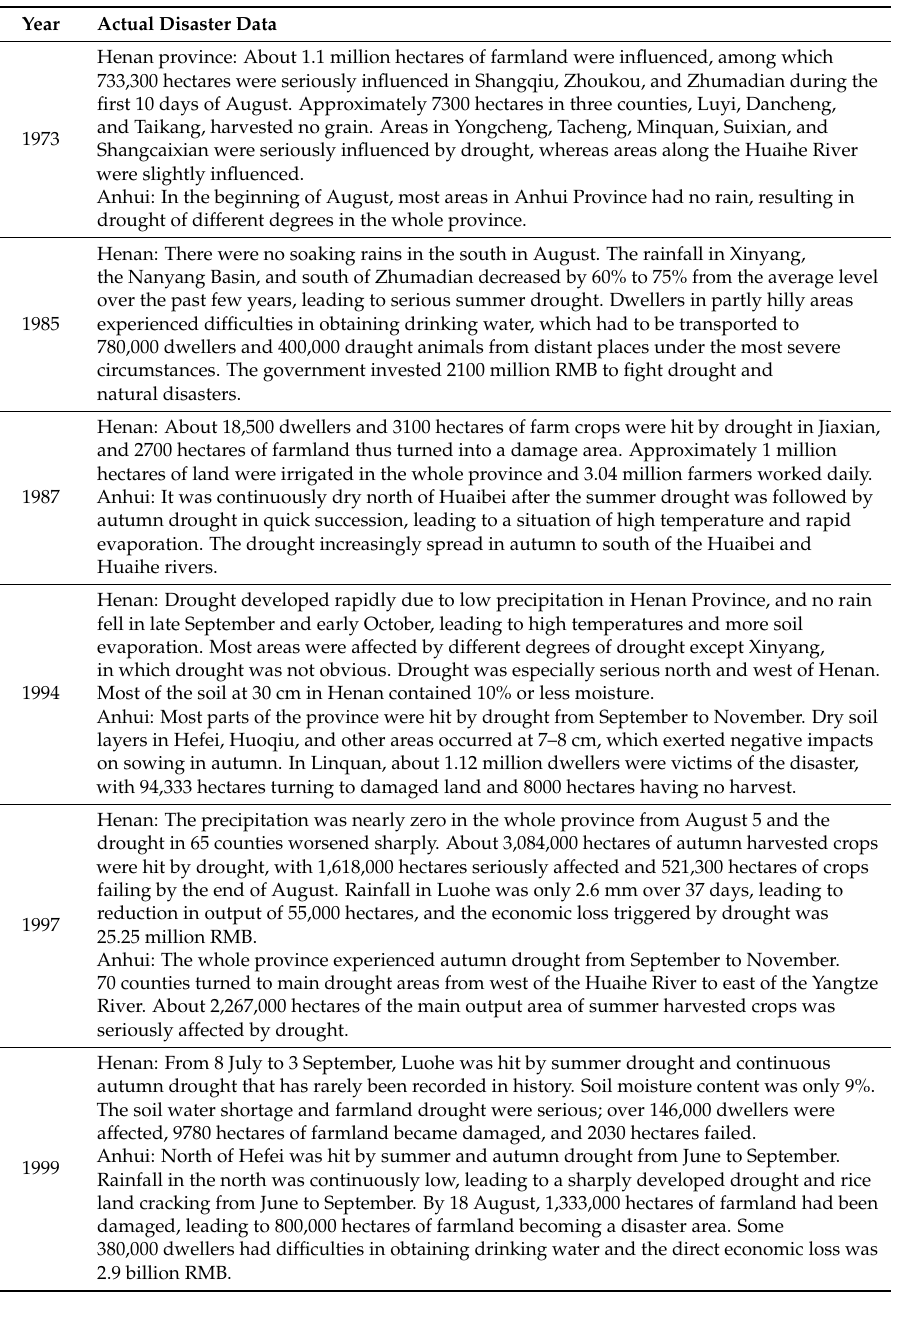
Table A1. The actual disaster data of drought for typical years in the